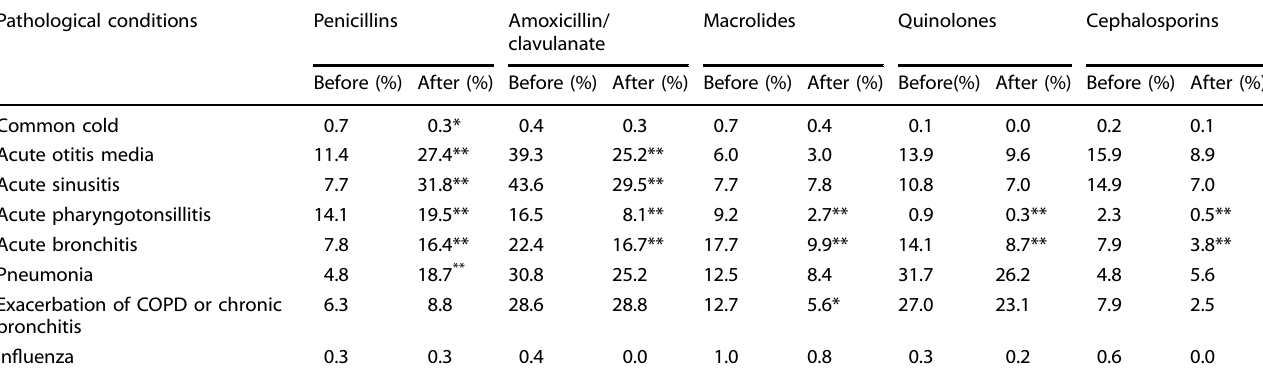
Table 4. Changes in the percentage of use of antibiotics for the different pathological conditions before and after the physician ’ s educational intervention.